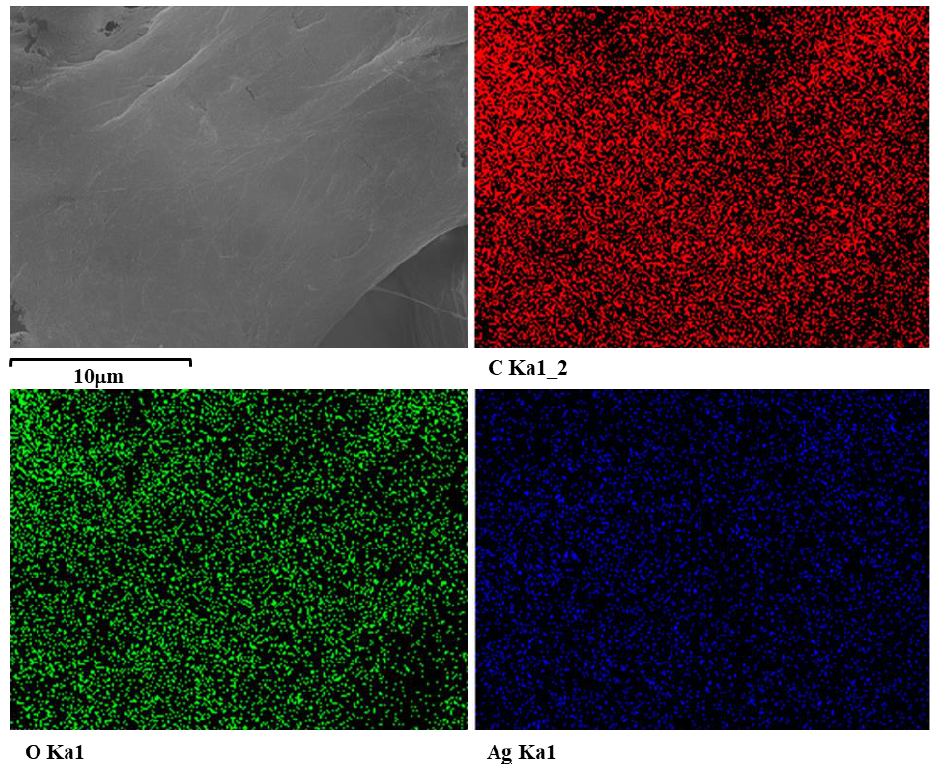
Figure 4. EDS elemental mapping images of the bhpFibers@AgNP-based paper.